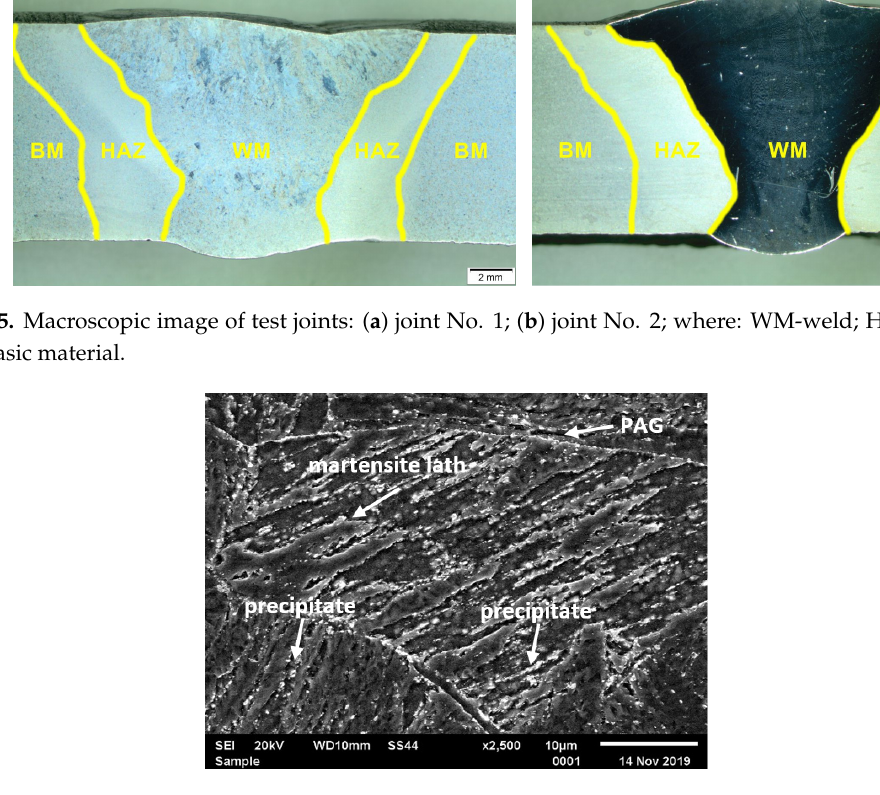
Figure 6. Microstructure of joint No. 1 in the vicinity of the fusion line—coarse grained heat-af- fected zone (CGHAZ). zone (CGHAZ).